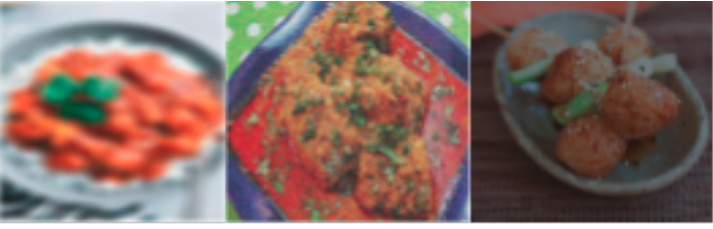
Figure 9. Defocus blur, Gaussian noise and Gaussian blur on randomly selected images.